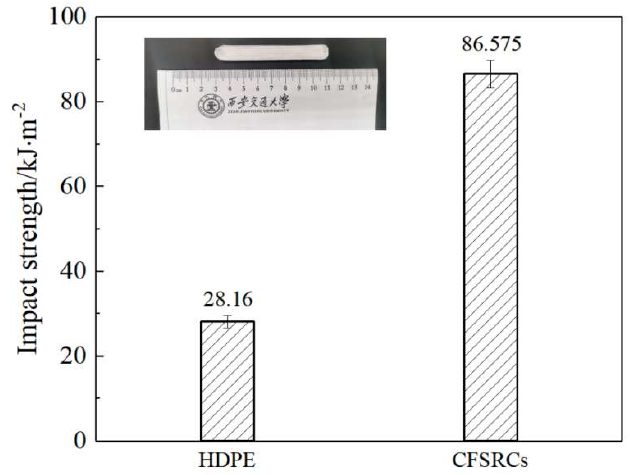
Figure 5. The impact strength of 3D-printed CFSRCs and HDPE.